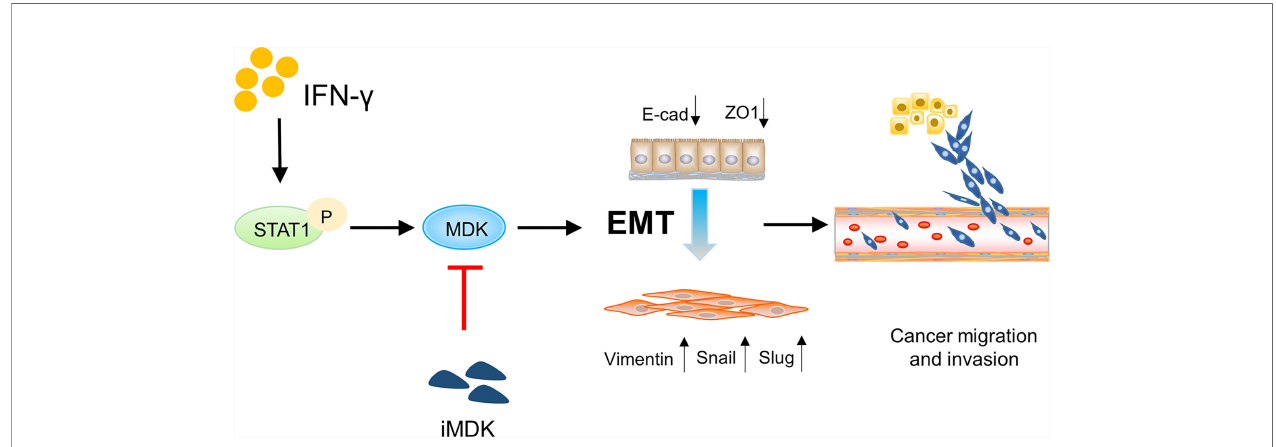
FIGURE 7 | Schematic diagram showing the IFN- g -STAT1-MDK signalling axis in driving cancer metastasis. The IFN- g -STAT1-MDK signalling axis promotes cancer metastasis by activating EMT, whereas MDK inhibition by iMDK can abrogate IFN- g -induced EMT and tumor